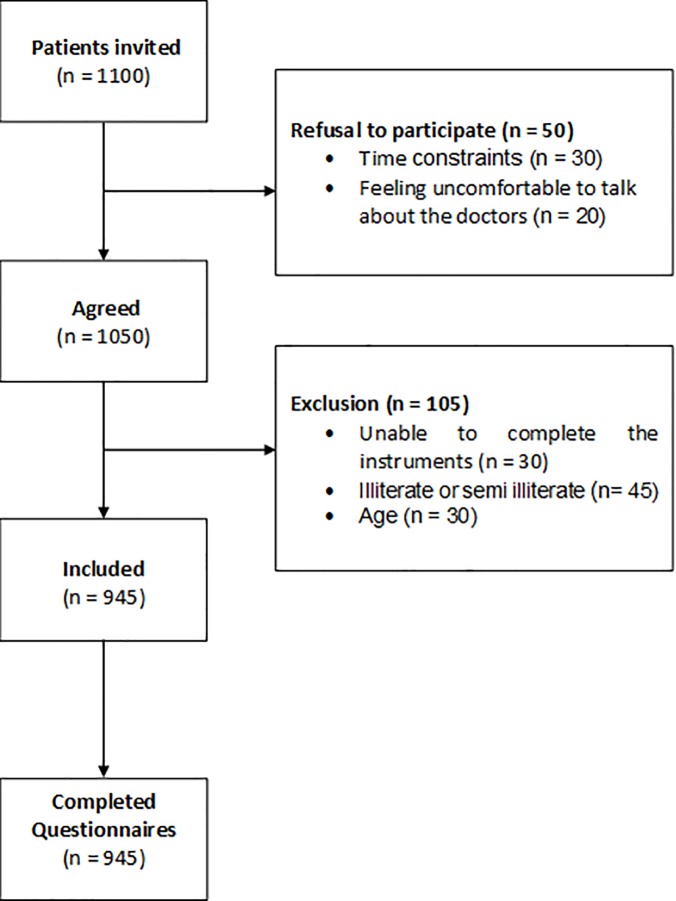
Patient´s flowchart.